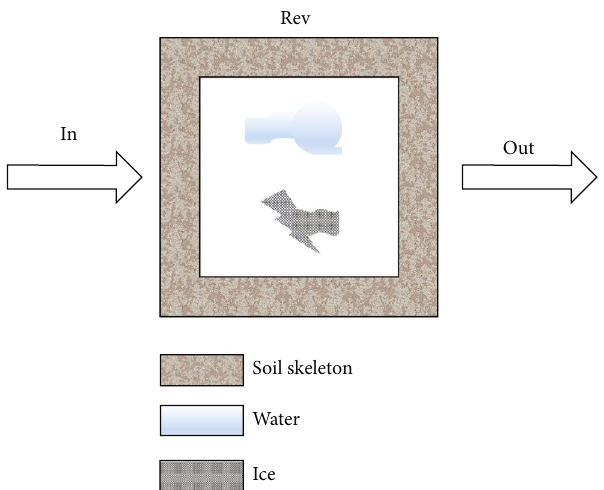
Figure 4: Simpli fi ed series (vertical)